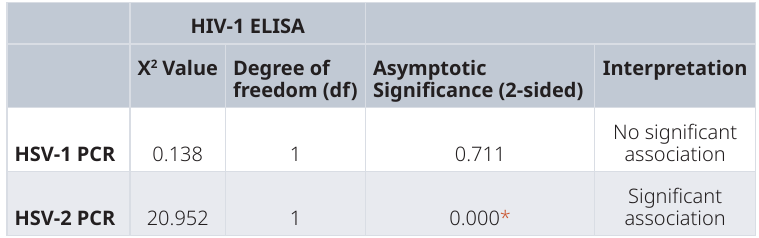
Table 4. Association between HIV-1 ELISA positive samples and HSV-1 and HSV-2 PCR positive samples. HIV-1